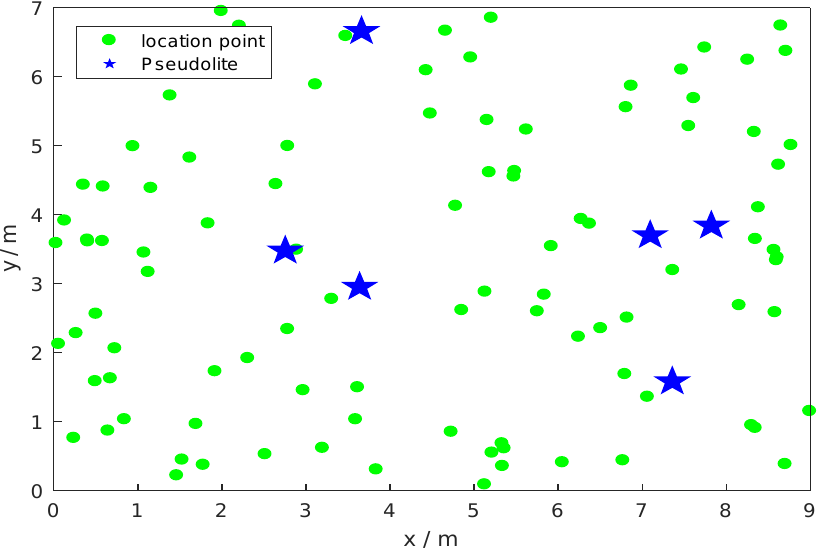
Figure 1. Six pseudolites and positioning points.